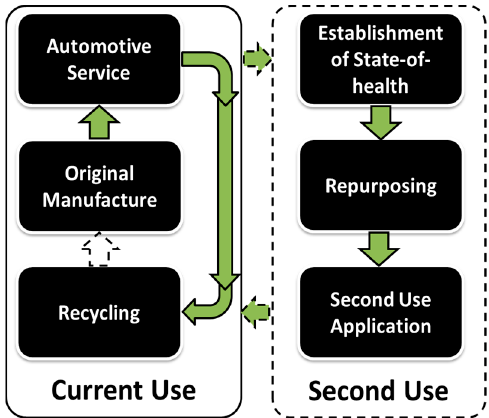
Figure 1. Possible vehicle battery life cycle [17].